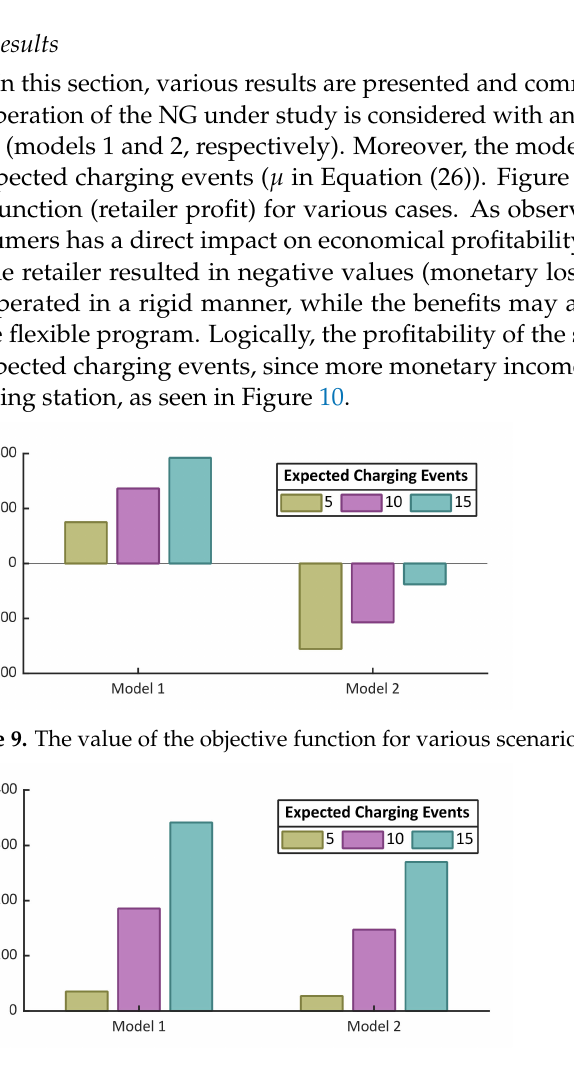
Figure 10. Monetary incomes obtained from EV charging processes in various